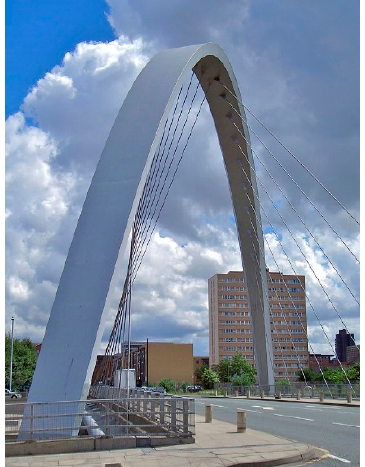
Figure 3. Hulme Arch Bridge, Manchester, UK (photo: Mike Peel, Wikimedia Commons).